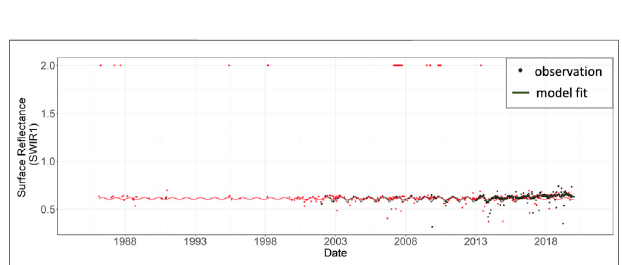
FIGURE 9 | The time series plot of using over- fi ltering AOT observations (in black) versus the regular AOT fi ltering strategy (in red) (Lat: 18.9903; Lon: − 14.7481). Note that no saturation fi ltering was applied here.